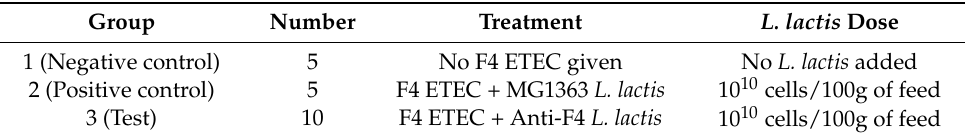
Table 1. Piglet groups and treatment. Group Number Treatment L. lactis